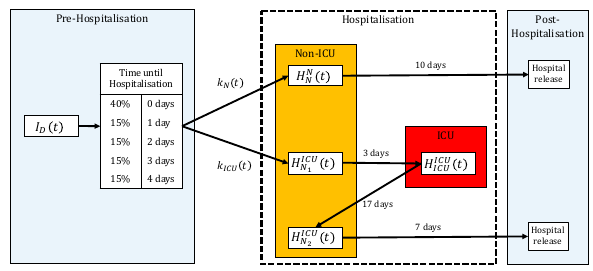
Figure 1. Hospital beds model and its